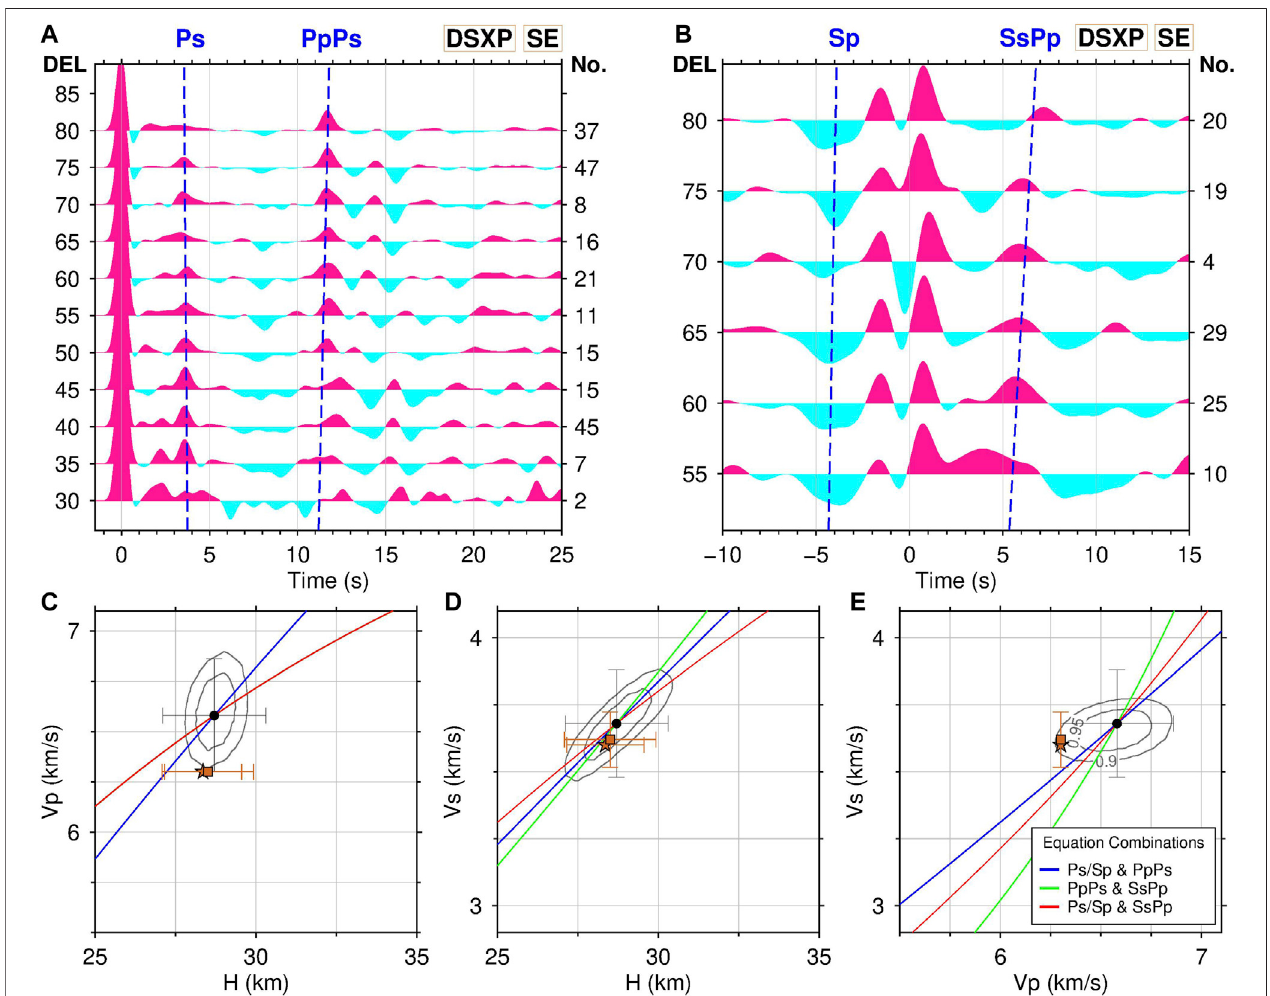
FIGURE2| IllustrationofourH-Vstackingapproachtodeterminecrustalthickness(H),averageVpandVsfortheSEquadrantofstationDSXP. (A) Pand (B) SRF stacksforevery5 ° epicentraldistancebinswiththeirrespectivepositiveandnegativepolarityphases denotedinmagenta andcyancolors.ThenumberofindividualRFs usedineachstackisdisplayedontheright.DashedbluelinesmarkthetheoreticalarrivaltimesofMoho-relatedphases( Ps , Sp , PpPs ,and SsPp )predictedfromtheH-V analysis. (C – E) Thecontoursofthede fi nedfunctiontobemaximizedinH-VgridsearchandouroptimalsolutionofH,Vp,andVs(blackcircle)shownbythepointof intersectionofthreecurves thatrepresentthearrival-timeequation combinations projected ontotheH-Vp, H-Vs, and Vp-Vs planes, respectively. Thetwogray contours represent the 90% and 95% con fi dence regions. The colored solid lines denote the curves of intersection of the three equations, mean(1,4), (2), and (5), associated with the theoretical arrival times of Ps / Sp , PpPs , and SsPp phases. The projected brown square and star represent the result of Guo et al. (2019) and He et al. (2014), respectively, for the same station DSXP.